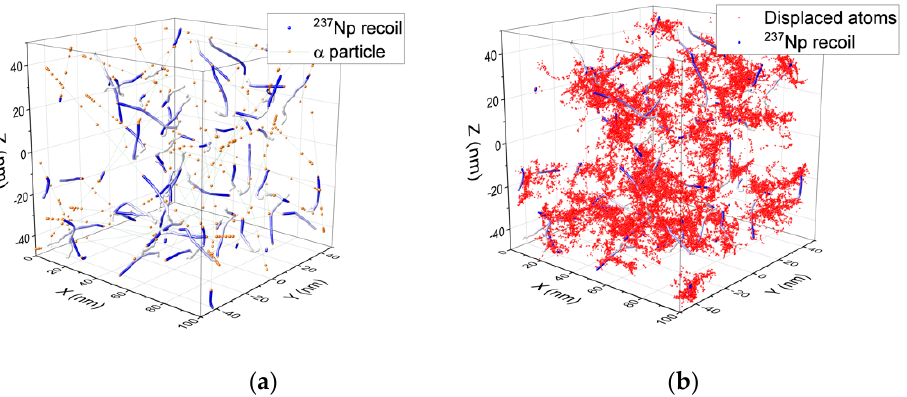
Figure 1. Simulation made with SRIM reflecting the level of damage that occurred in an SF14 cube with a 100 nm side over 1 day, i.e., 1.6 × 10 − 2 dpa. ( a ) 237 Np recoil atoms (blue dots) and alpha particle paths (orange dots). ( b ) Recoil cascades (red dots) and 237 Np recoil atoms (blue dots).